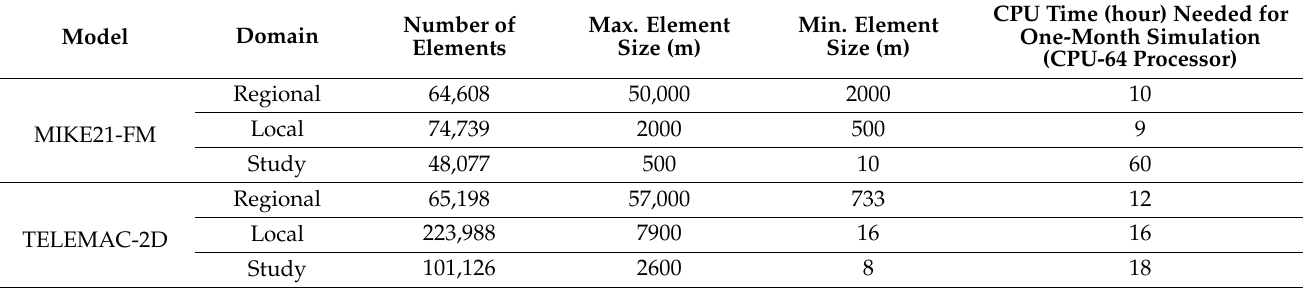
Table 1. Parameters of regional, local, and study